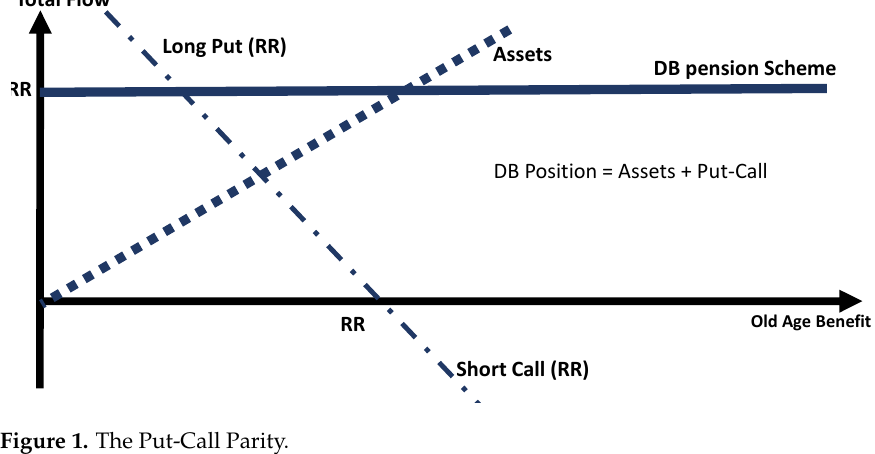
Figure 1. The Put-Call Parity.